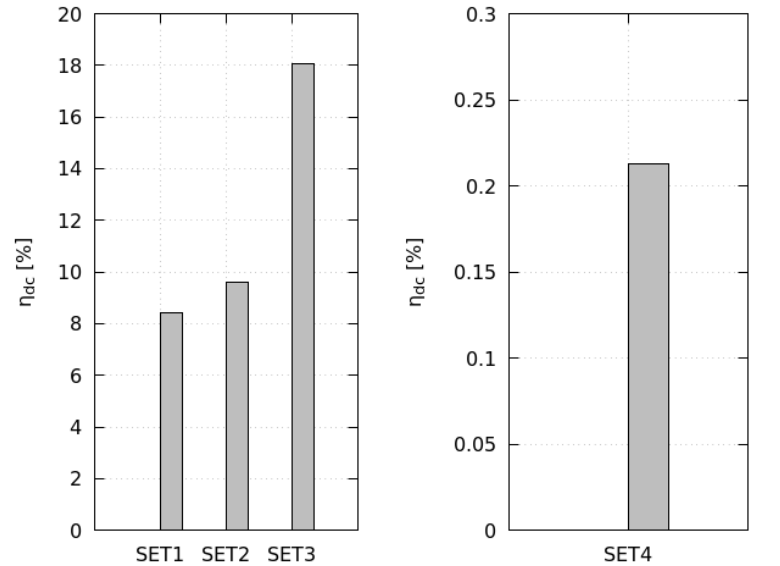
Figure 12. Drying efficiency η dc .